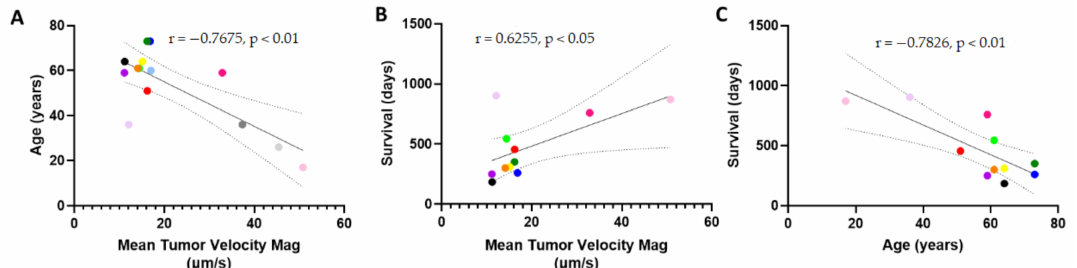
Figure 3. Patient survival and age correlate with tumor interstitial fluid velocity magnitude. ( A ) Age vs. mean tumor velocity magnitude. ( B ) Survival in days vs the mean tumor velocity magnitude averaged over six slices per patient. ( C ) Age vs. survival in patients analyzed for interstitial fluid velocity. Correlations are shown with 95% CI, and colors indicate different patients and are consistent with Figure 2, CI = confidence interval.